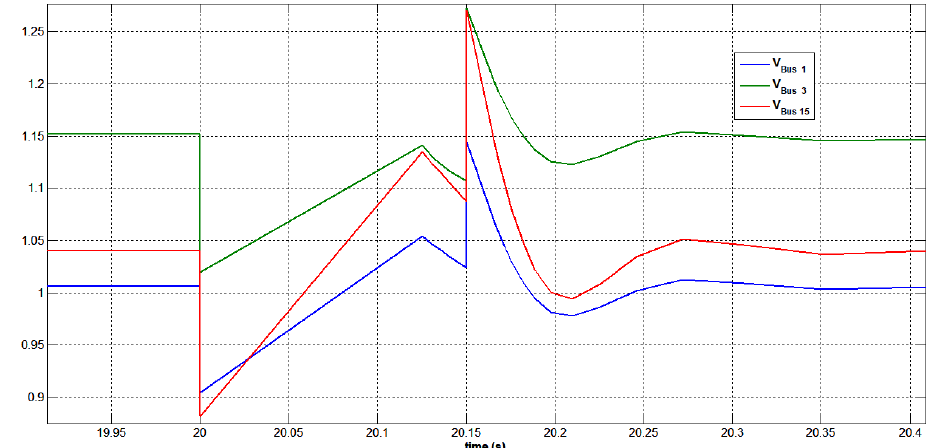
Figure 40. Voltage variation at buses 1, 3, and 15 under a three-phase short circuit at bus 15 without STATCOM.